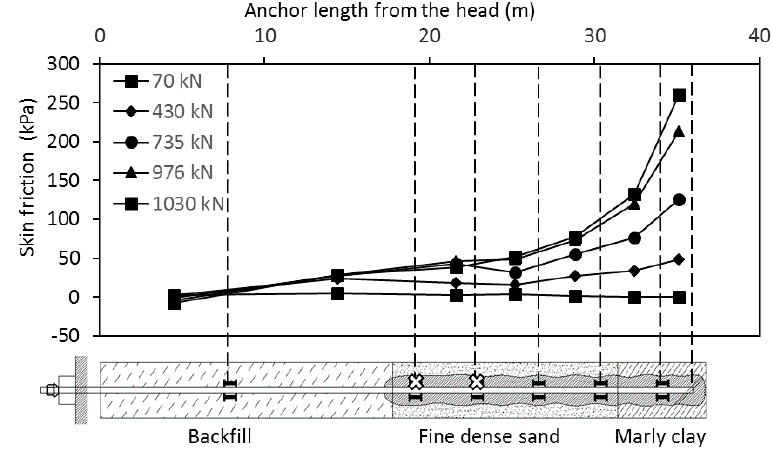
Figure 7. Distribution of skin friction in the soil / grout interface along the anchor T1.